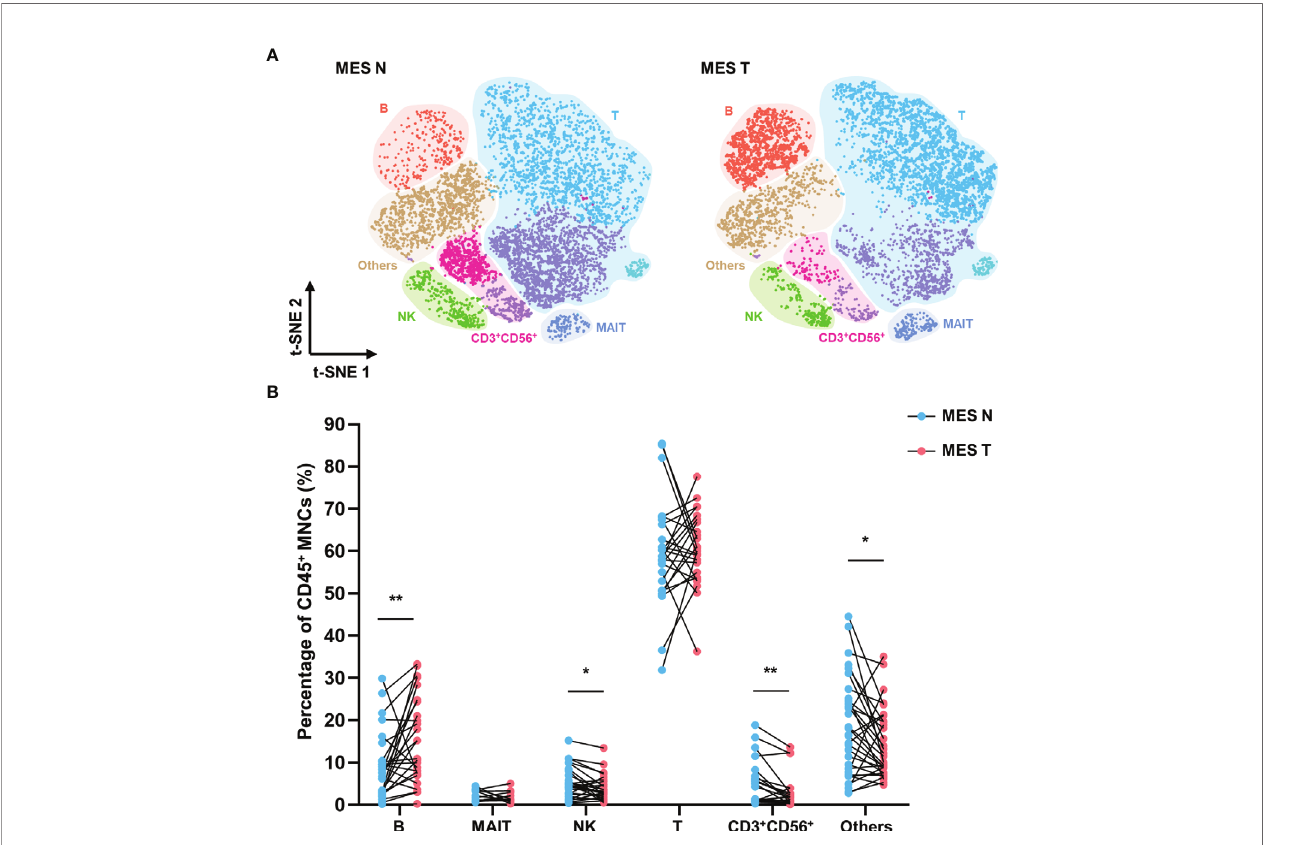
FIGURE 3 | T-SNE plot and percentages of CD45 + MNCs in the MES N and MES T (A) T-SNE plot of CD45 + MNCs in the MES N and MES T with main subclusters indicated. (B) Percentages of B cells, MAIT cells, NK cells, T cells, CD3 + CD56 + cells, and other cells (monocytes/macrophages and dendritic cells) in the MES N and MES T. (*p < 0.05; **p <